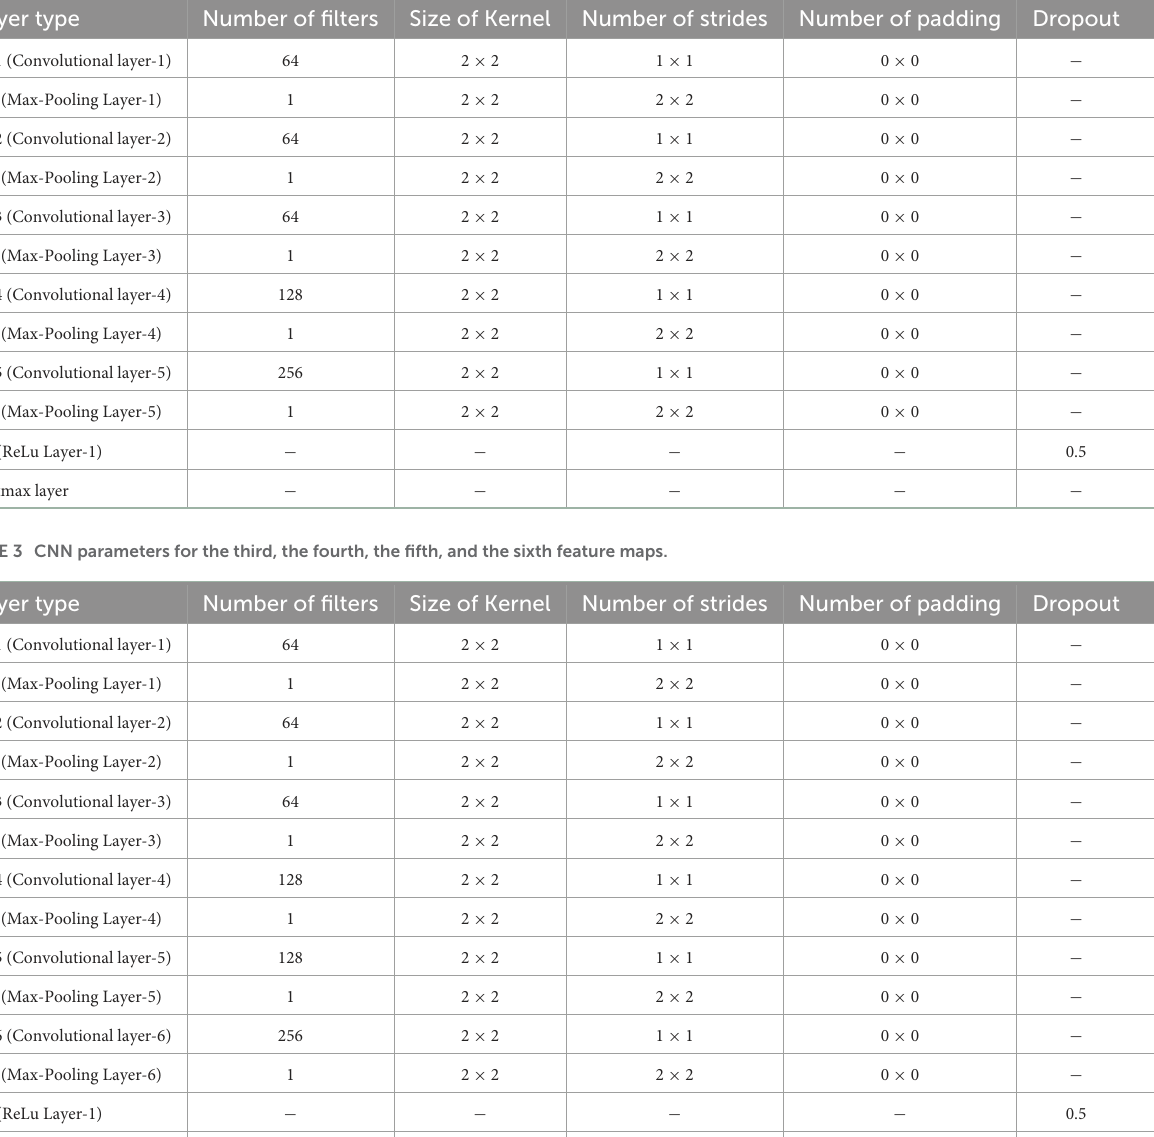
TABLE 2 CNN parameters for the first and the second feature maps.